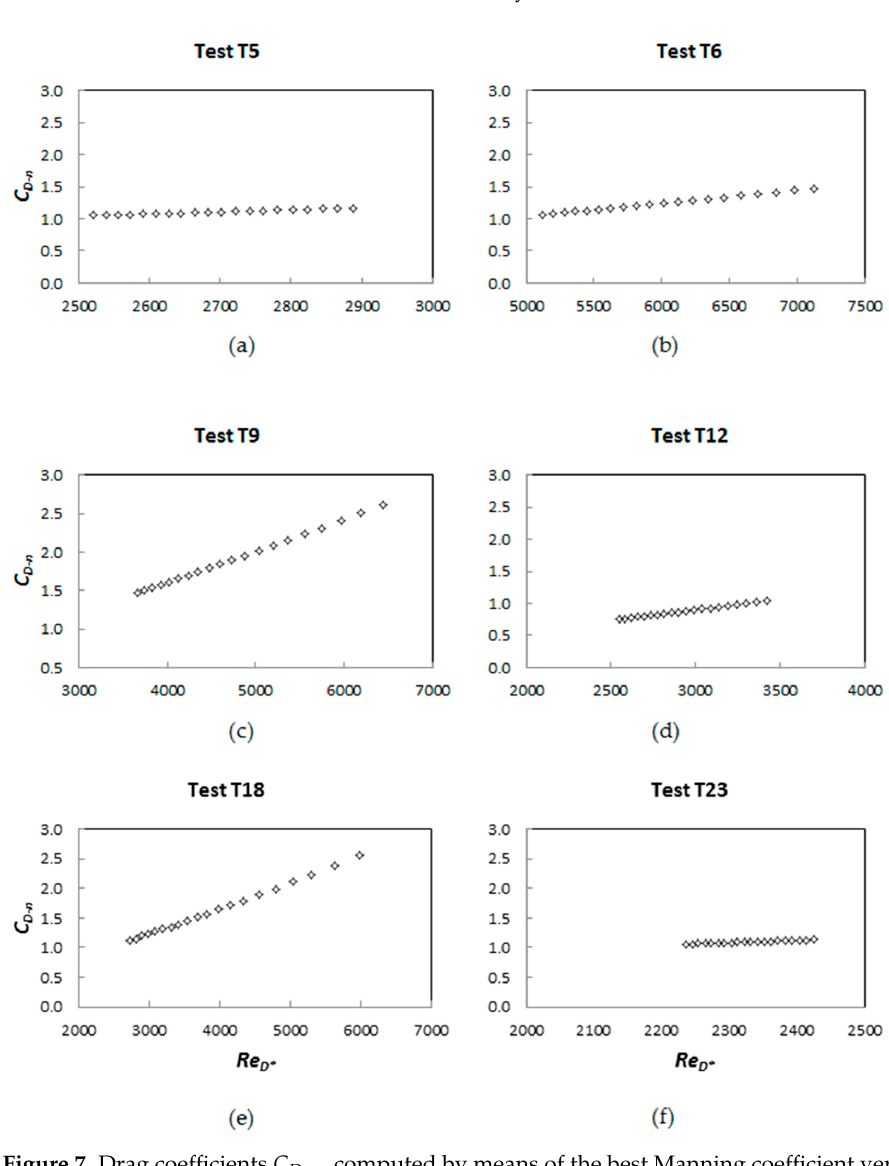
Figure 7. Drag coefficients C D − n computed by means of the best Manning coefficient versus Re D ∗ : ( a ) T5 ; ( b ) T6; ( c ) T9; ( d ) T12; ( e ) T18; ( f ) T23.